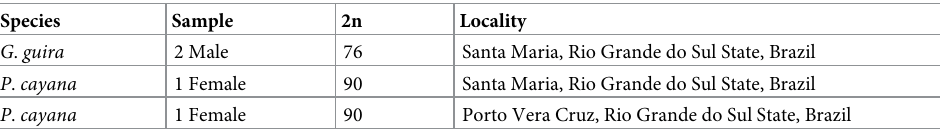
Table 1. Characterization of the samples used in this